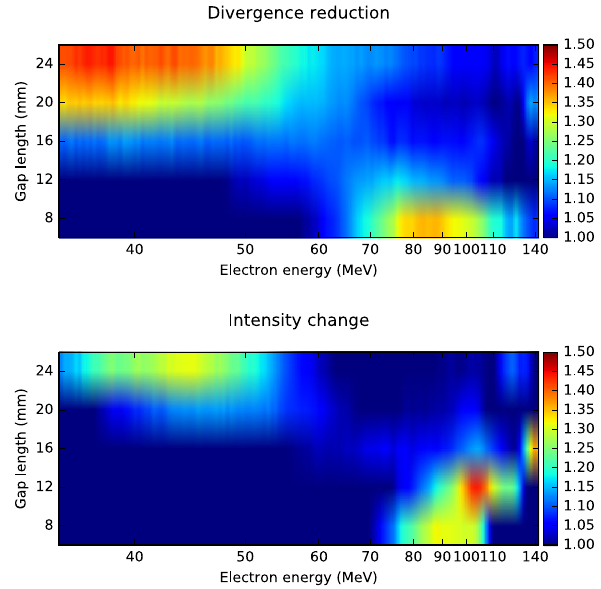
8. The spectral dependence of the plasma lens measured with five different gap lengths: The color maps show the = θ with lens divergence reduction ( ¼ θ without lens , upper panel) and div div the relative intensity change on the lanex screen (lower panel). Both measurements are in good agreement, since a divergence reduction is followed by an increase in spectral intensity. The data is obtained by an average over 40 – 50 shots for each gap length using the same data set as in Fig.